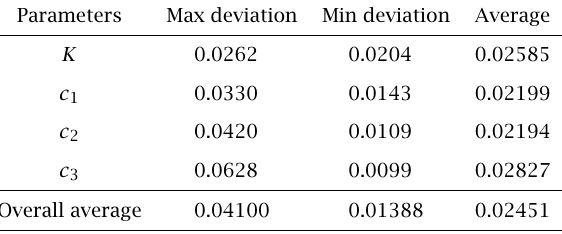
Table 3.1 . Average deviation of Problems I as a function of the parameters K , c 1 , c 2 , and c 3 .